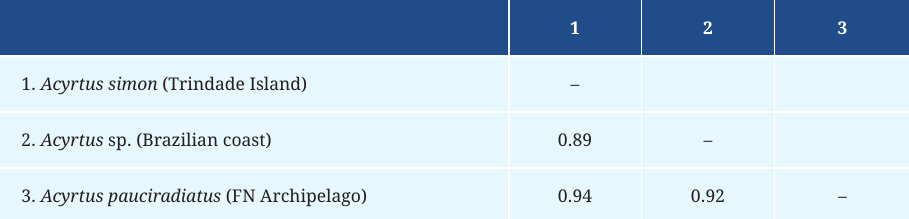
TABLE 5 | F index among Acyrtus in the Southwestern Atlantic. All values were significant (p<0.05). ST